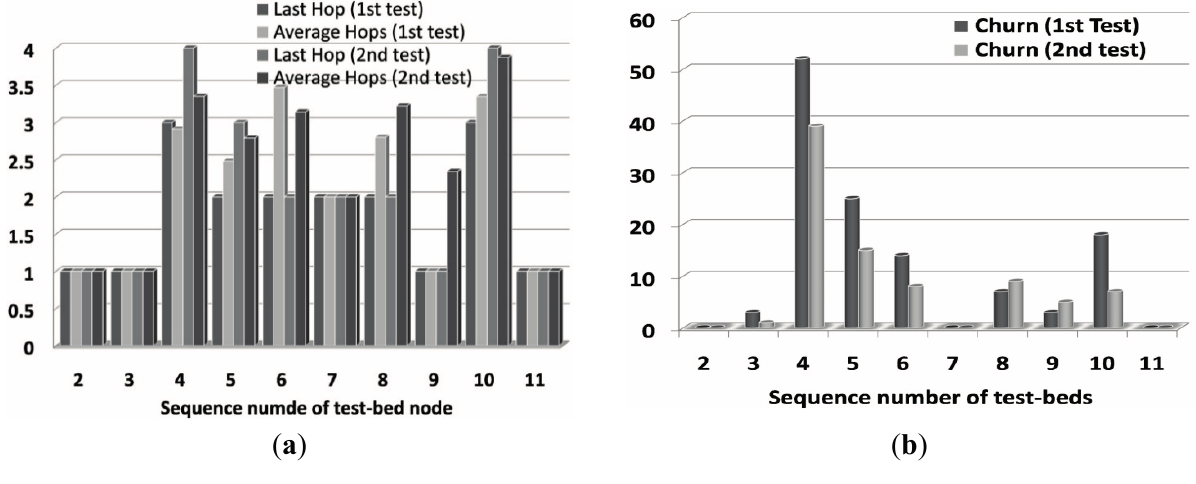
Figure 7. ( a ) Hop count evaluation results; ( b ) Number of network churns for the testbeds in the 1st and 2nd